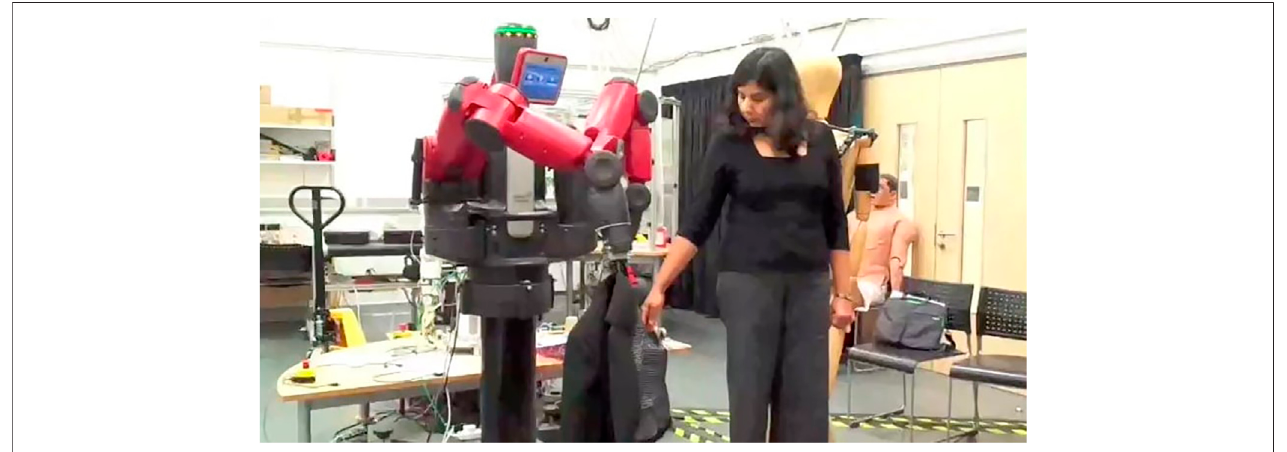
FIGURE 1 | Dressing assistance task performed by a